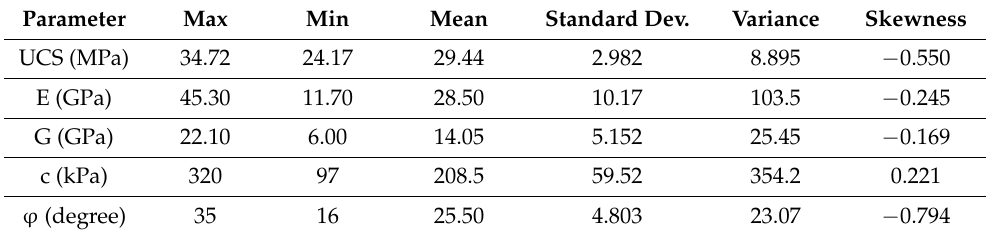
Table 2. The geo-engineering properties of the South Pars